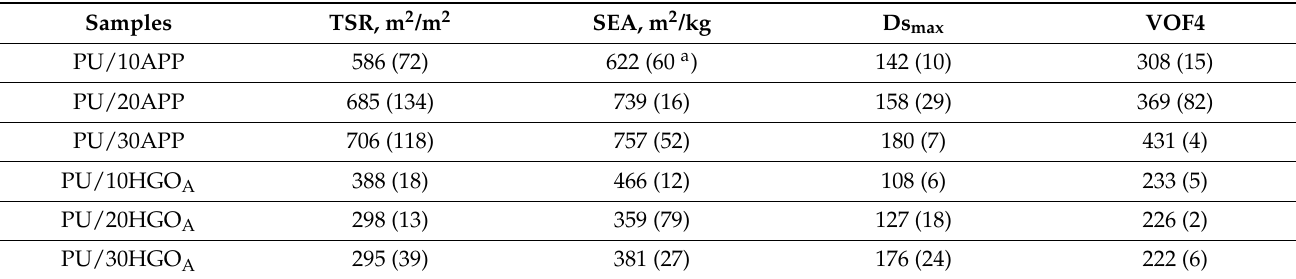
Table 8. Smoke emission of unmodified PU and polyurethane foams with APP or HGO A system. Samples